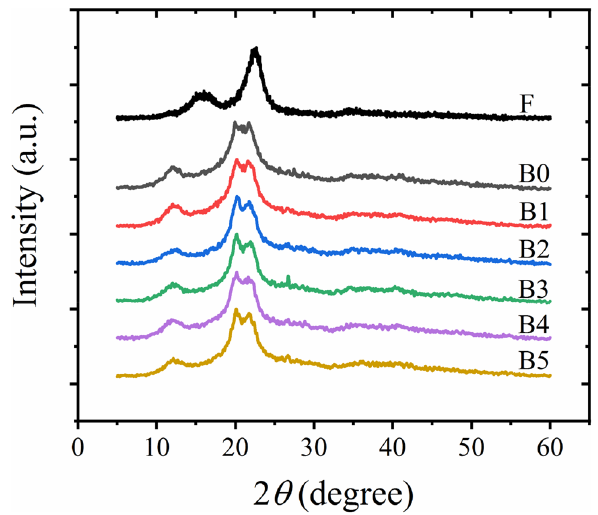
Figure 3. X-ray diffraction (XRD) patterns of purified water hyacinth fibers (F) and cross-linked cellulose hydrogels with various concentrations of